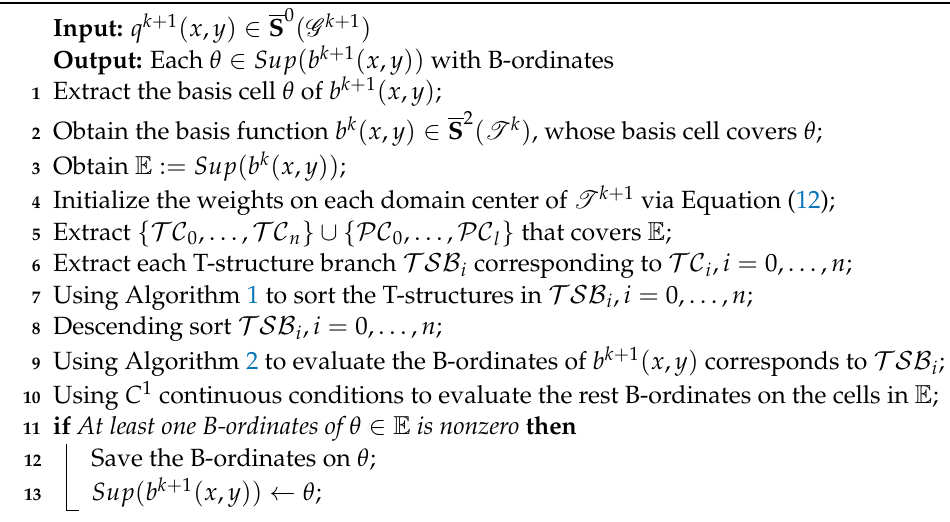
Algorithm 3: Calculating the B-ordinates for b k + 1 ( x , y ) ∈ S